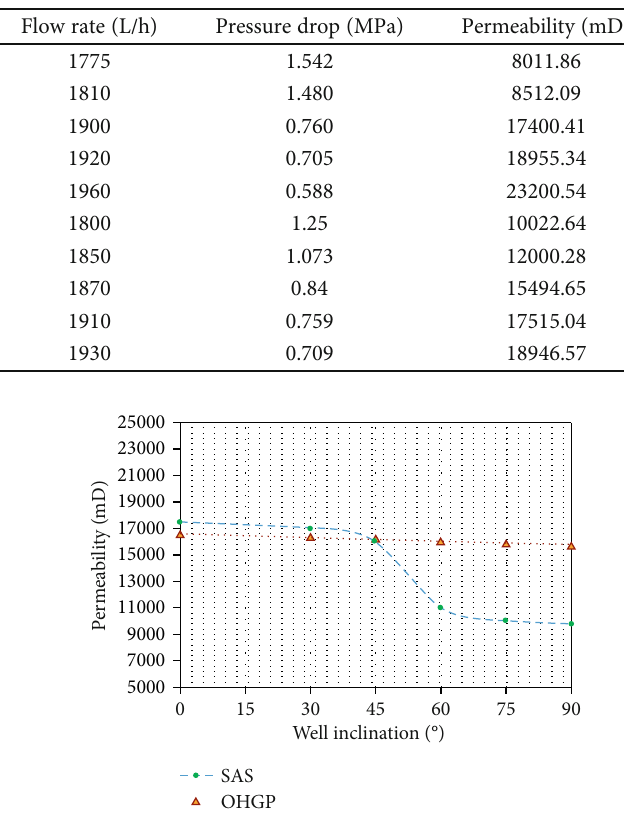
Figure 11: The e ff ect of di ff erent well inclinations on the permeability of the